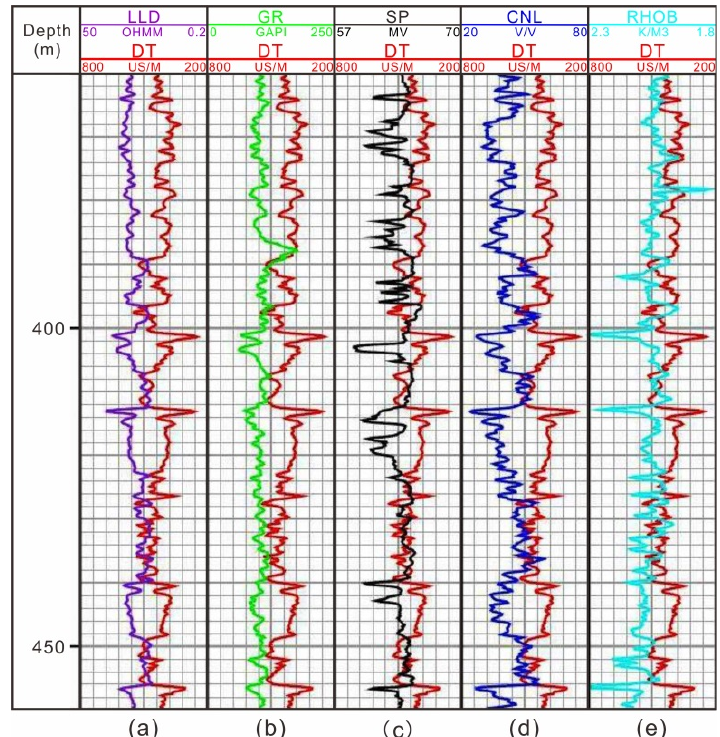
Figure 3. The analysis of the correlation between acoustic and other logging data: ( a ) Acoustic and resistivity, ( b ) Acoustic and gamma, ( c ) Acoustic and spontaneous potential, ( d ) Acoustic and CNL, ( e ) Acoustic and RHOB.